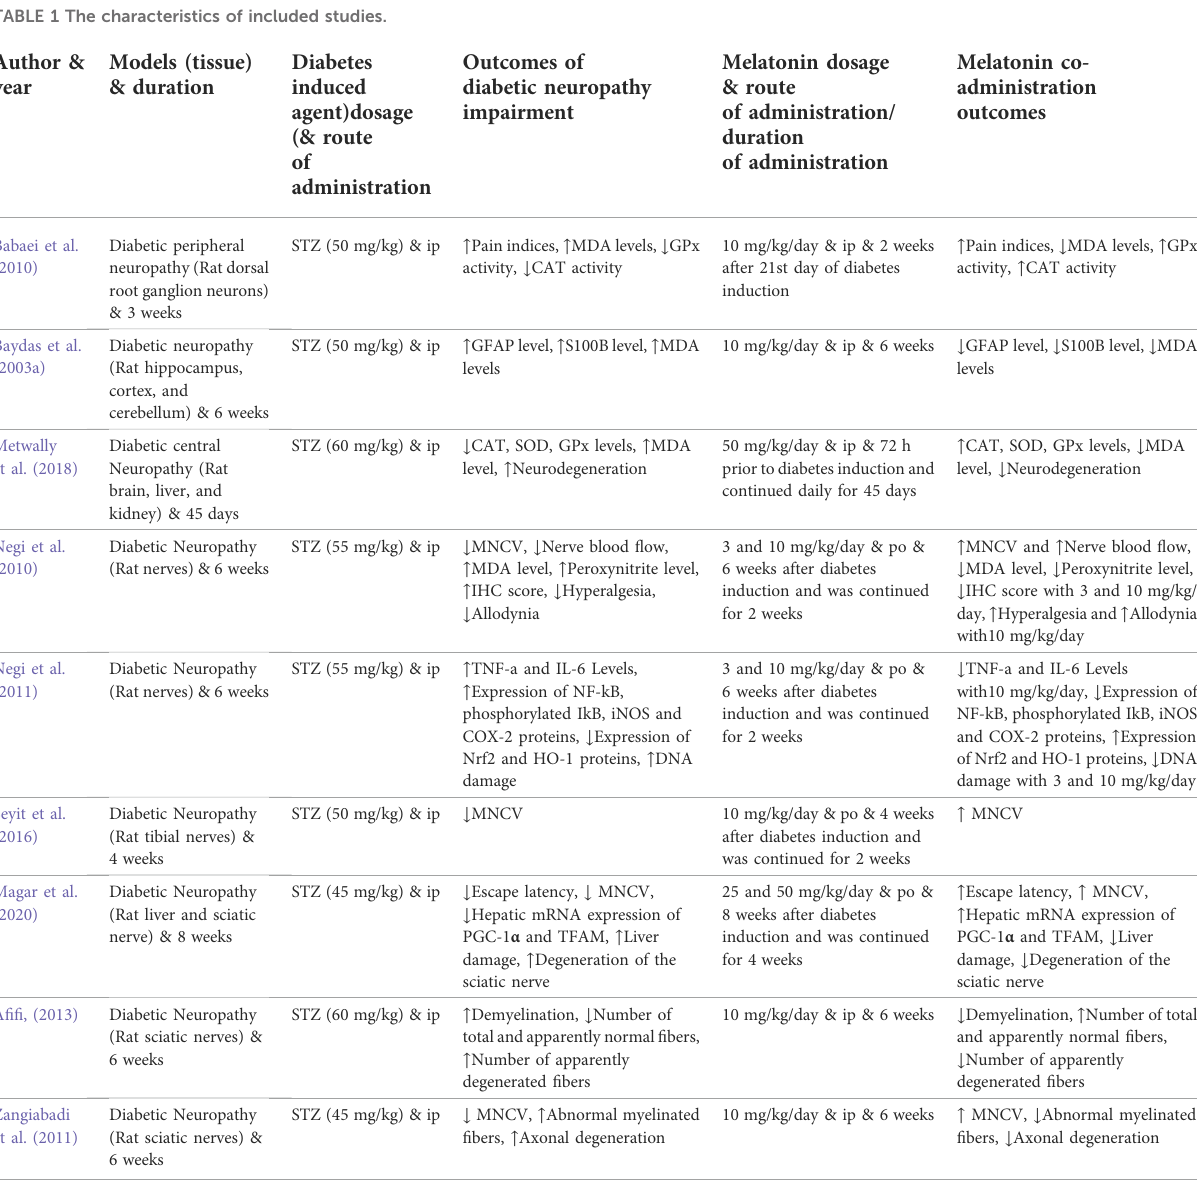
TABLE 1 The characteristics of included